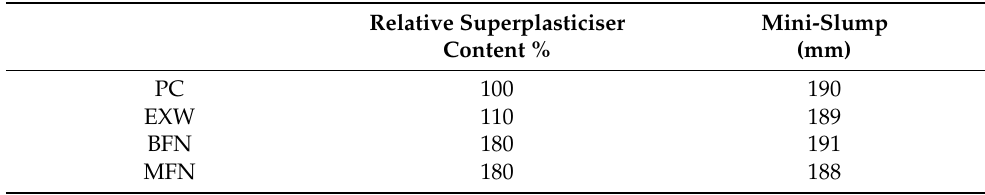
Table 9. Relative percent of superplasticiser and mini-slump of the mortar mixtures.